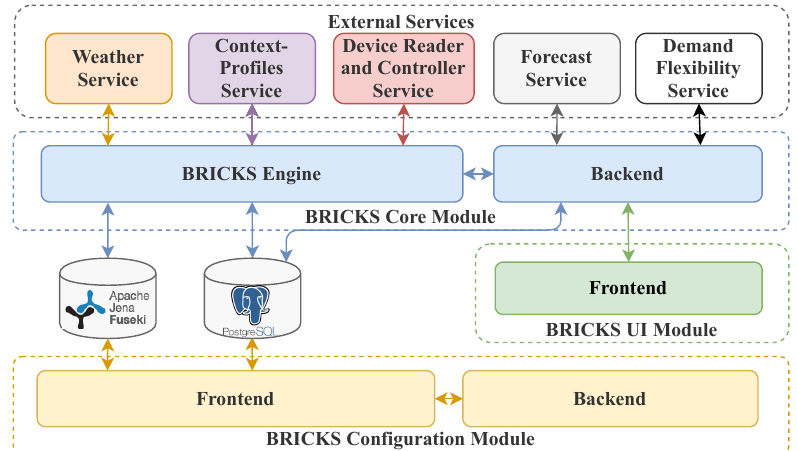
Figure 1. BRICKS’